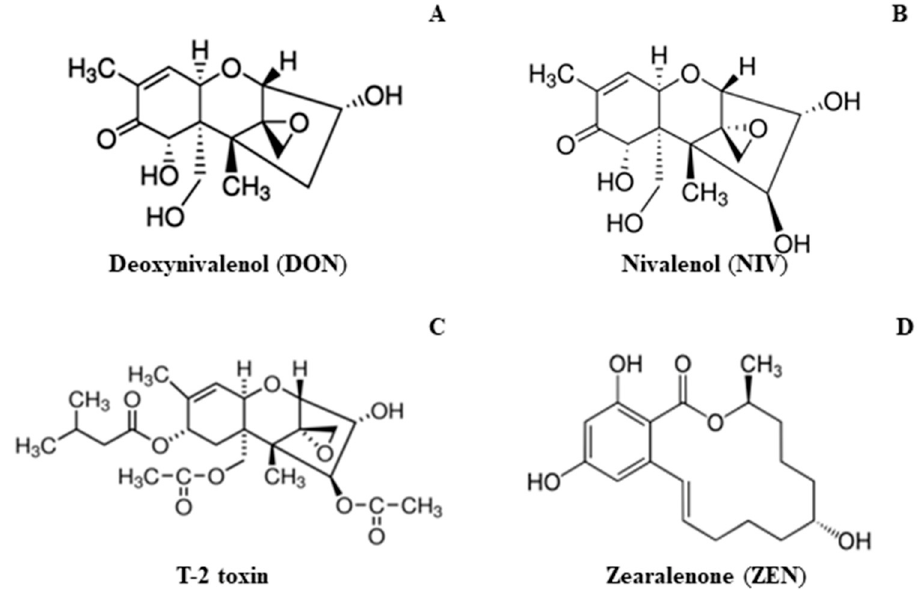
Figure 1. Secondary metabolites (mycotoxins) produced by Fusarium culmorum : ( A ) deoxynivalenol (DON), ( B ) nivalenol (NIV), ( C ) T-2 toxin, ( D ) zearalenone (ZEN).Source: Sigma-Aldrich.